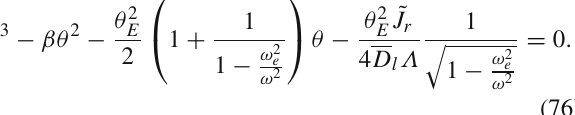
Fig. 14 Plot of ˆ α vs. b for SIS (continuous line), NSIS (dashed line), and PGC (dot-dashed line). We used Λ = 0 . 1, r c = 10, r 0 = 10, /ω 2 = ω 2 /ω 2 = 0 . 5. For NSIS we use sin χ = 1, s = 0 . 03, and ω 2 c f Λ = 1 since no difference from SIS was found